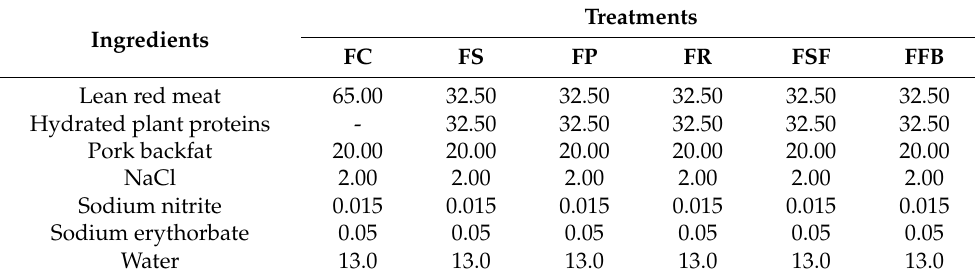
Table 1. Formulations (g/100 g) of hybrid meat emulsions elaborated with plant proteins as partial meat